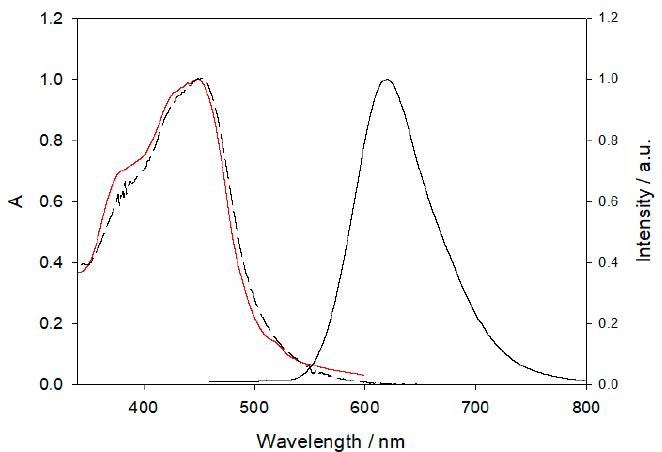
Figure 5. Normalised absorption (black dashed line), emission (black line) and excitation (red line)